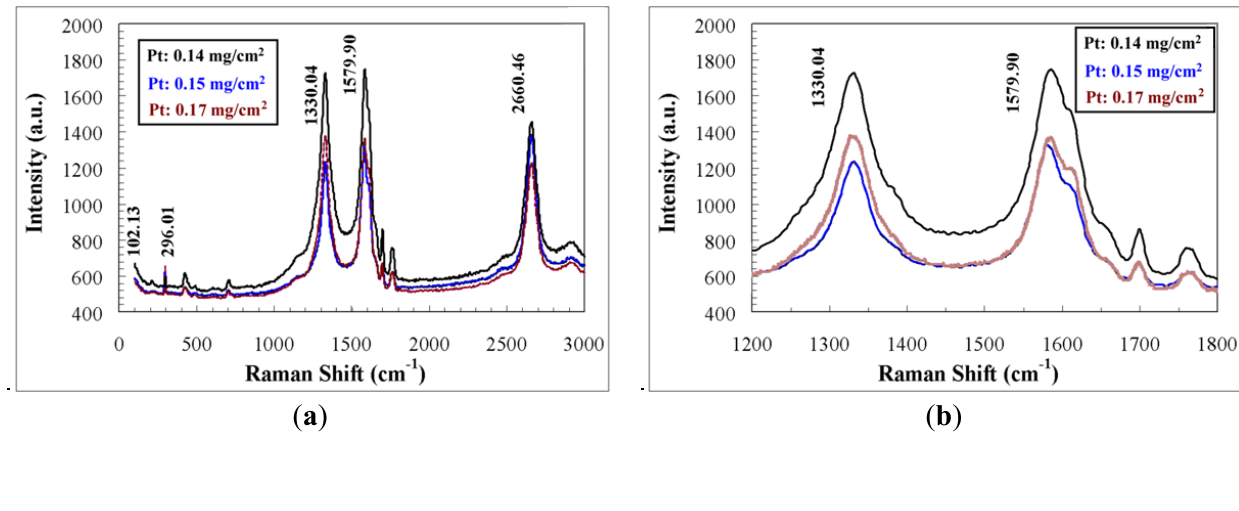
Figure 4. The Raman spectroscopic analyses of Pt-functionalized ACNT (three selected samples were shown): ( a ) Raman spectra for MEA; and ( b ) zoomed-in Raman spectra of these three